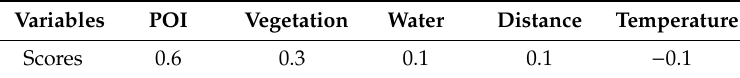
Table 2. Weighting scores of all